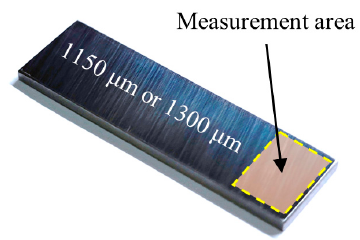
Figure 3. Standard gauge block for pre ‐ experimentations.